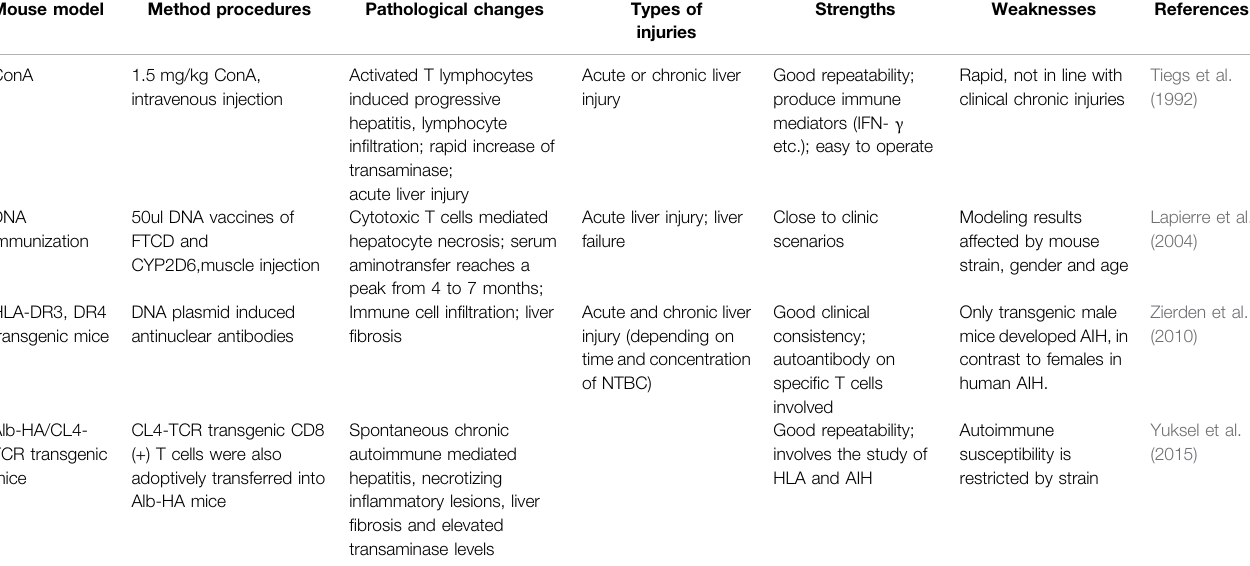
TABLE 5 | Mouse models of autoimmune hepatitis